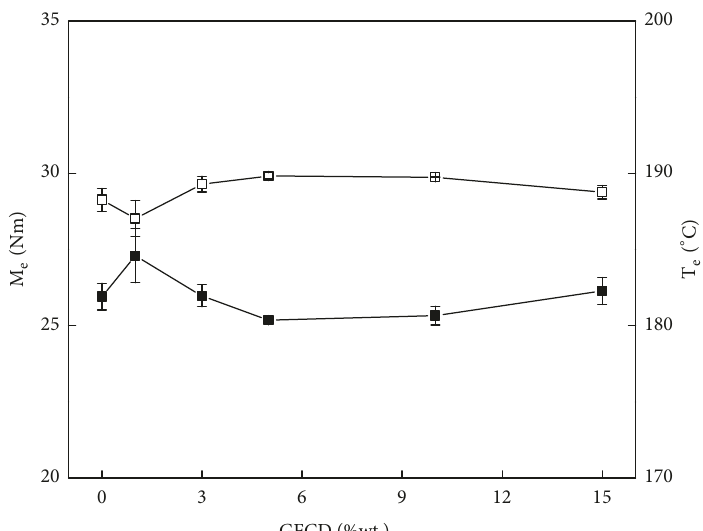
Figure 5: Torque at the end point M content in PVC.